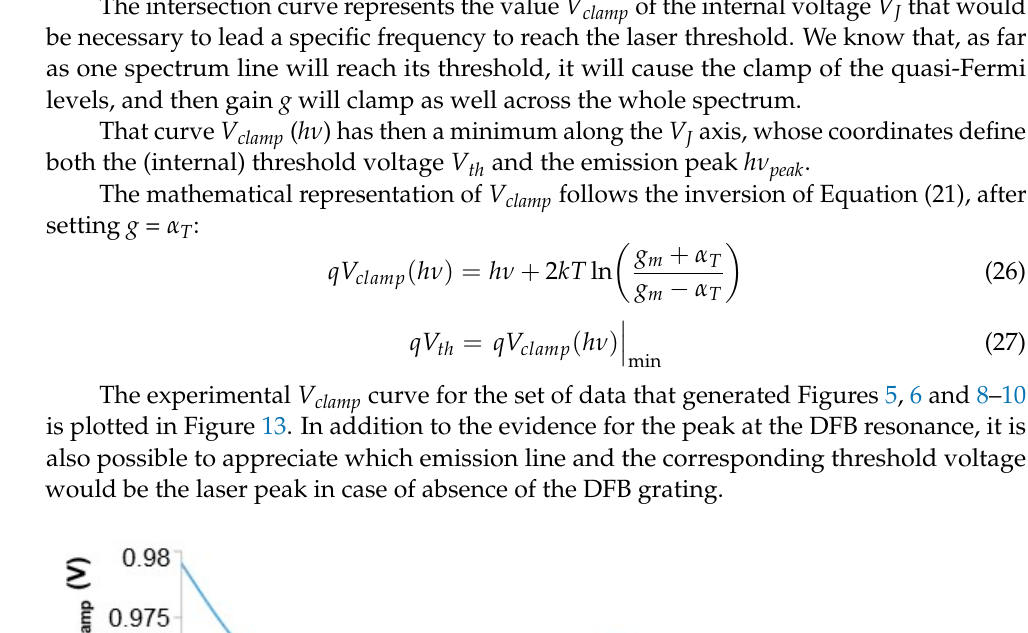
Figure 12. ( a ) Plot of the intersection of the gain g and loss α T surfaces; ( b ) the same plot, limited to the V J < V th range.